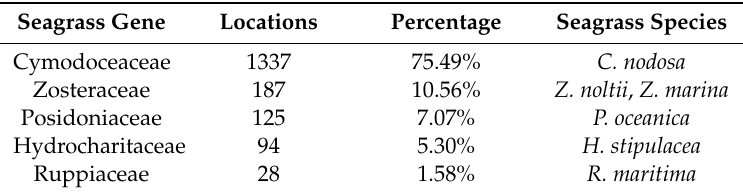
Table 1. Seagrass family frequency in the United Nations Environment Programme—World Conservation Monitoring Centre (UNEP-WCMC) dataset (last column presents seagrasses at species level).